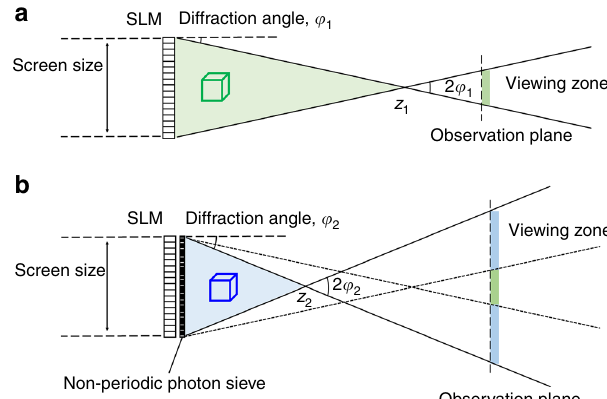
Fig. 1 The concept of the holographic display using a non-periodic photon sieve. a Schematic of a lensless digital holographic display system using a single spatial light modulator (SLM). The small diffraction angle of the SLM limit the viewing angle of the holographic objects. b Schematics of a large- sized wide viewing angle holographic display system using a non-periodic photon sieve. The photon sieve diffracts light at a high angle, thus increases the viewing angle. To guarantee the whole holographic image can be observed without disruption within the viewing angle, the holographic objects should be positioned in the shaded region. Outside the region, the holographic objects are clipped, and the viewing angle is